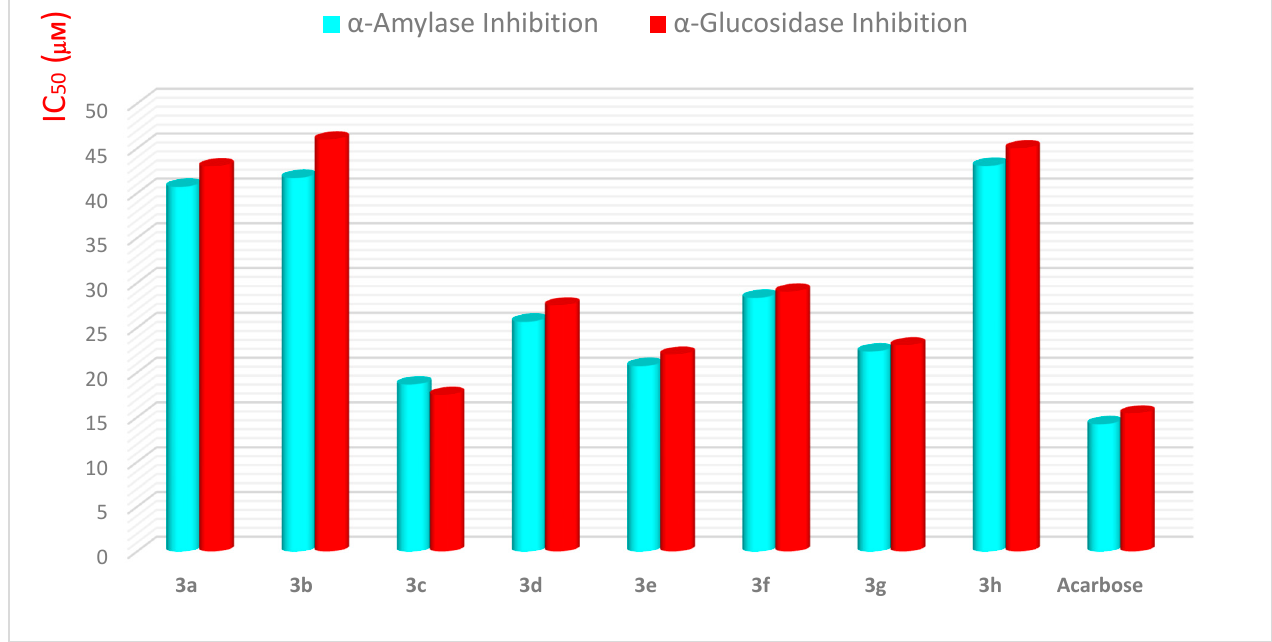
Figure 3 . Benzimidazole-ureas 3a-h inhibition activity against α -amylase and α -glucosidase. Figure 3. Benzimidazole-ureas 3a-h inhibition activity against α -amylase and α